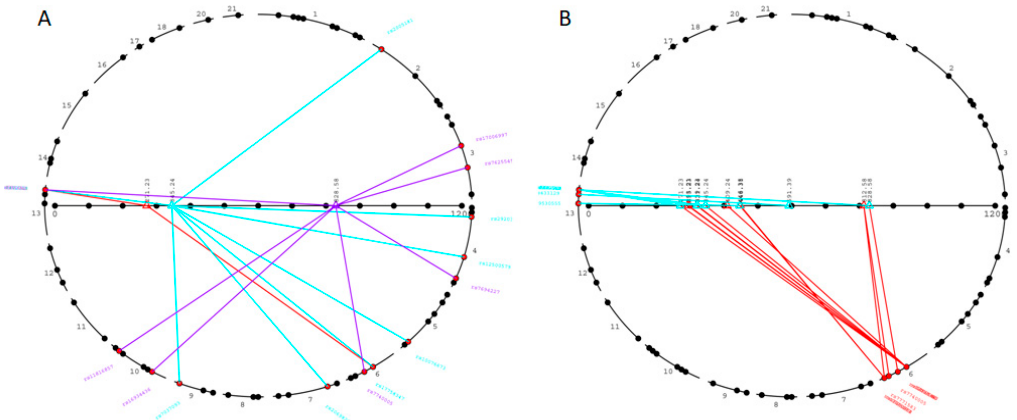
Figure 3. Architectural characteristics of genetic associations to metabolic features. Evidence of pol- ygenic control of metabolites ( A ) and potential pleiotropic effects of genetic loci on metabolite abun- dance ( B ) were identified, following metabolomic analysis of serum samples of 273 individuals. The colours of the lines indicate the chromosomal location of SNP loci showing evidence of significant association (LOD > 8), with the abundance of a specific metabolic feature. Evidence of polygenic control of the abundance of metabolic features was found for compounds characterized by mass-to- charge ratios (horizontal axis) of 271.23 (red), 345.24 (blue) and 828.58 (purple) ( A ). Potential plei- otropic effects were detected for SNP loci on chromosomes 6 (red lines) and 13 (blue lines), signifi- cantly associated with metabolic features characterized by distinct mass-to-charge ratios on the hor- izontal axis ( B ). Details of genetic results are given in Supplementary Table S2.